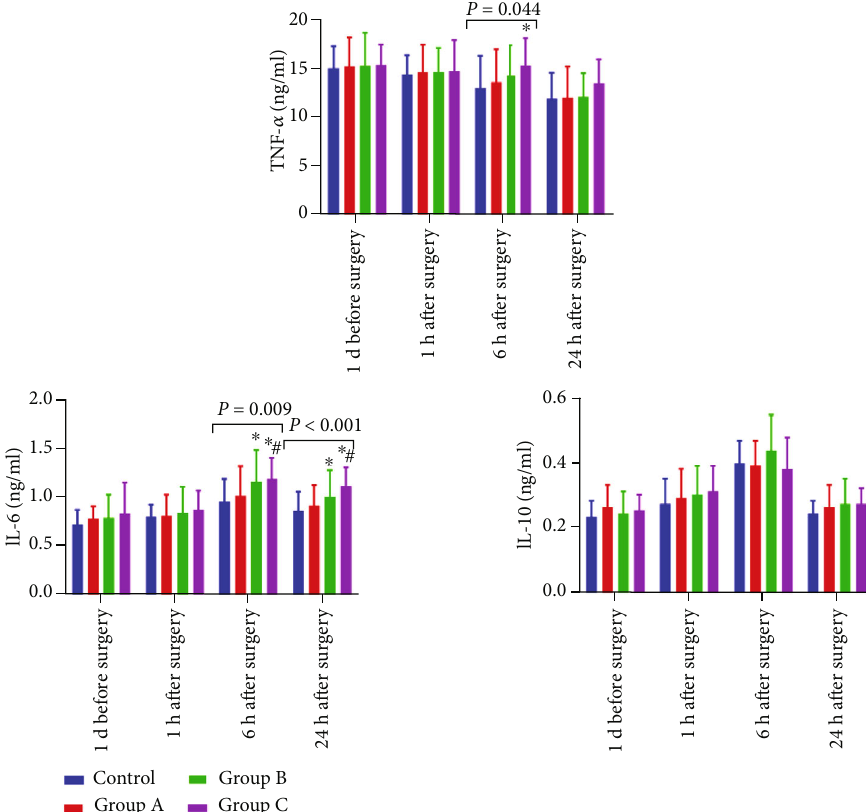
Figure 3: Comparison of in fl ammatory factor level ( n = 30 ). Note: compared with control group, ∗ P < 0 : 05 ; compared with group A, # P < 0 : 05